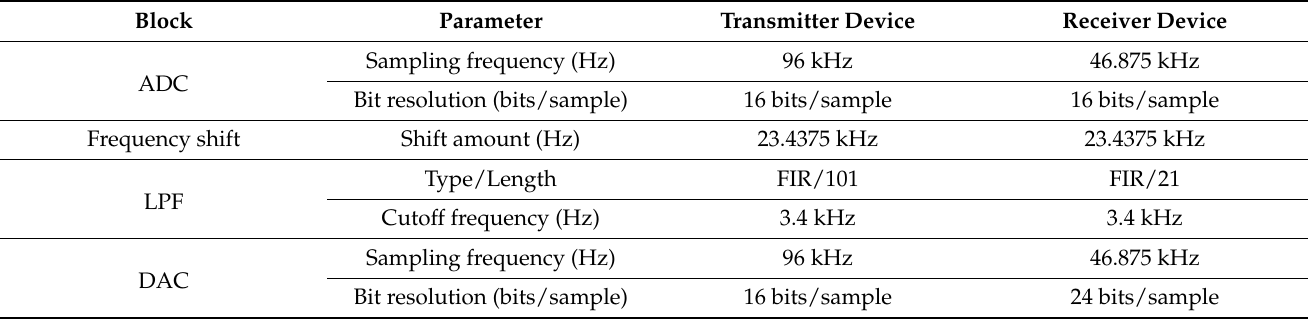
Table 1. Summary of parameters for transmitter and receiver